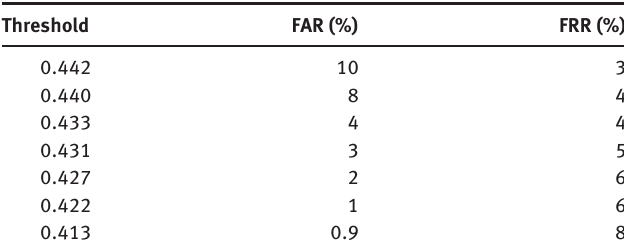
Table 4. FAR and FRR for the CASIAV3.0 Data Set with Different Separation Points Using the Optimum Parameters and Cosine